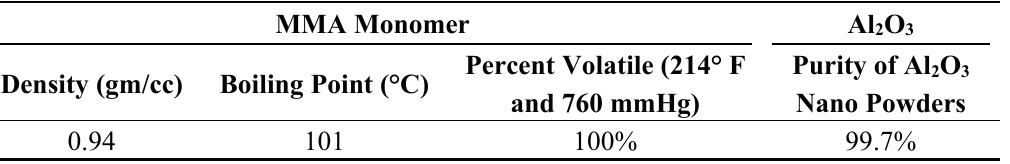
Table 1. The specifications of used